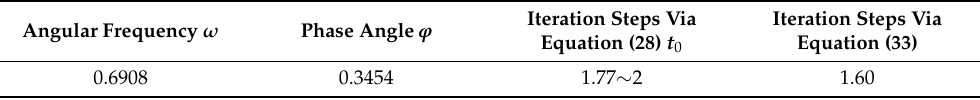
Table 4. Iterations for finding the target